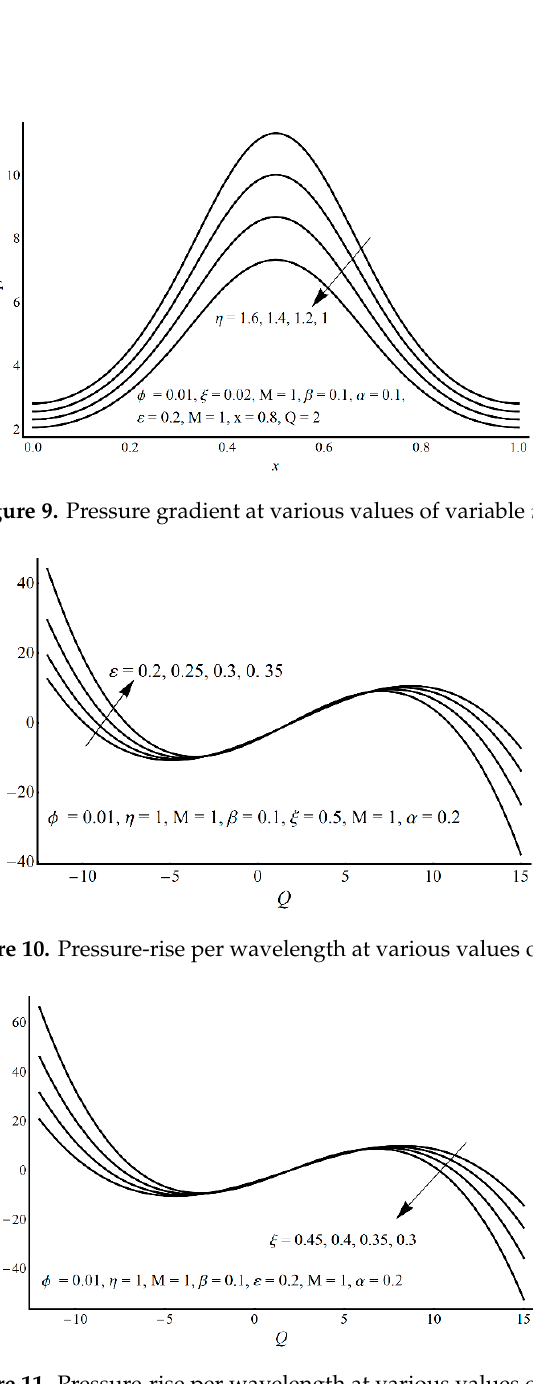
11 of 22 Figure 6. Axial velocity for various values of fluid material parameter η . Figure 7. Pressure gradient at various values of variable ε .